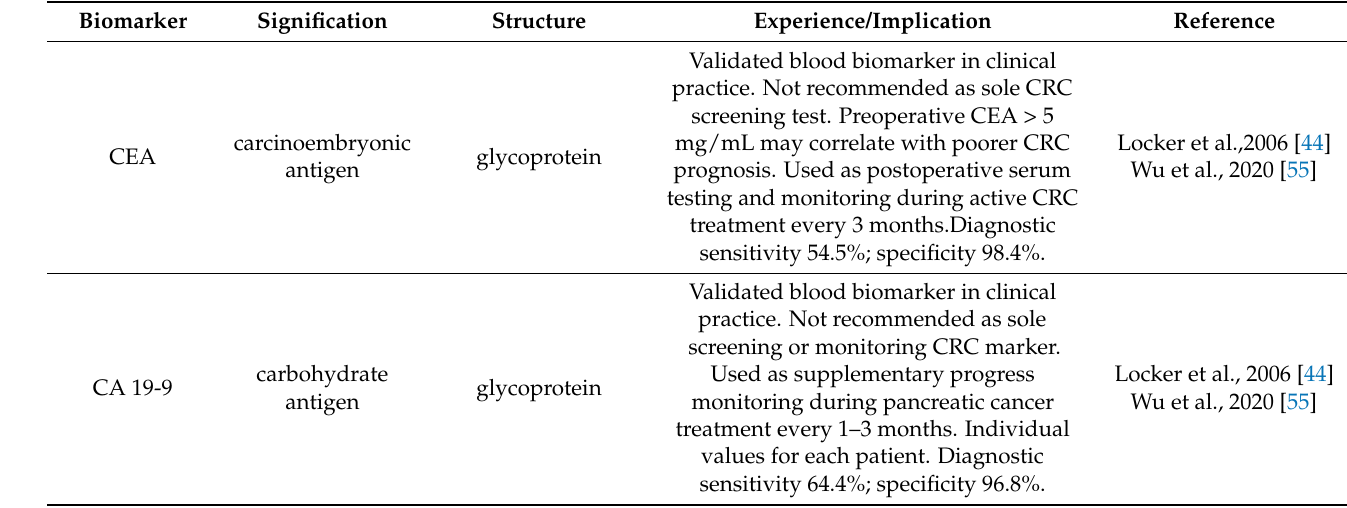
Table 1. Biomarker usage related to